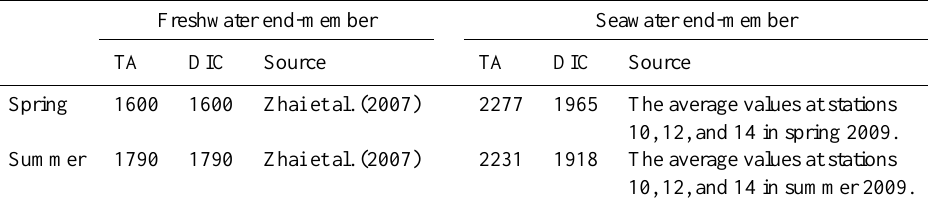
Table 1. The seasonal freshwater and seawater end-members of TA and DIC in spring and summer.